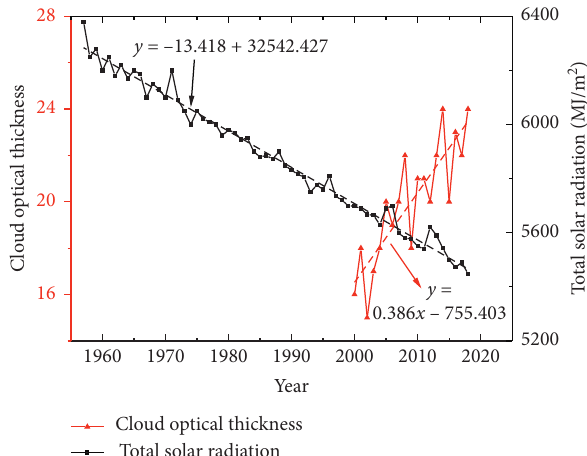
Figure 17: Annual variations in spatially averaged values of cloud optical thickness and total solar